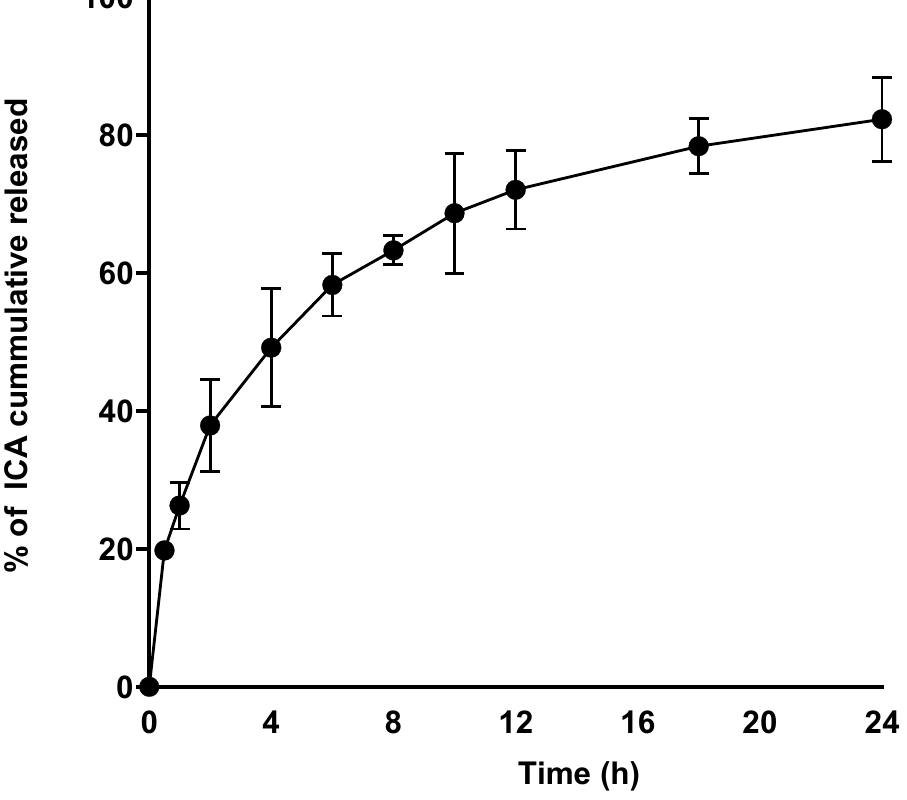
Figure 9. In vitro release profile of ICA from optimized ICA–tocozeinolate.